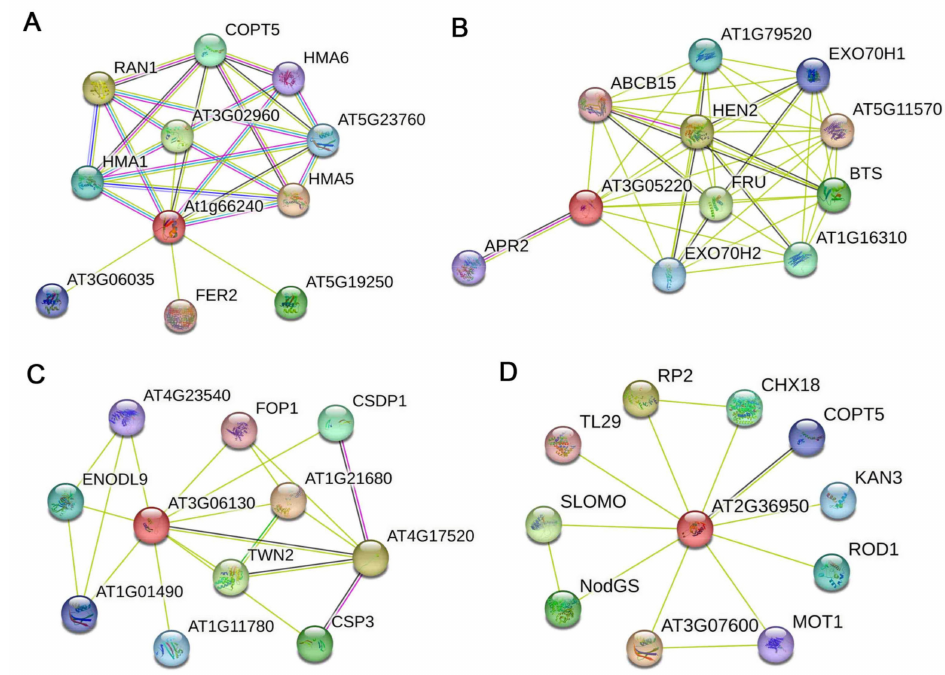
Figure 11. Network of protein–protein interactions of HMPs in A. thaliana . ( A ) AT1G66240 ( BrHMP41 homologous gene) PPIs. ( B ) AT3G05220 ( BrHMP06 and BrHMP42 homologous gene) PPIs. ( C ) AT3G06130 ( BrHMP16 homologous gene) PPIs. ( D ) AT2G36950 ( BrHMP36 homologous gene) PPIs. Individual nodes indicate a protein, and interactions are linked by